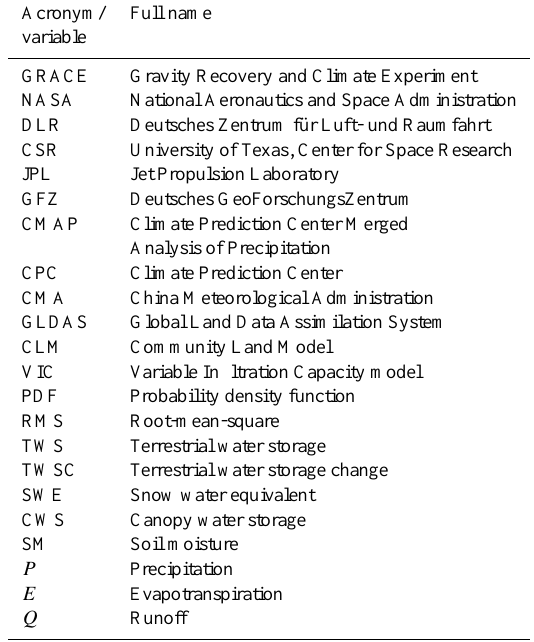
Table 1. List of main acronyms and variables used in the paper. Acronym/